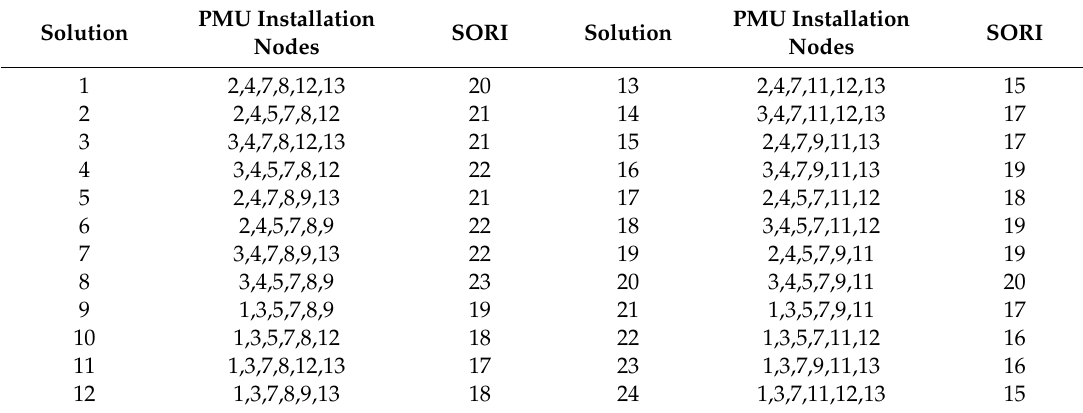
Table 2. Phasor measurement unit (PMU) placement solutions for a 13-node test feeder without